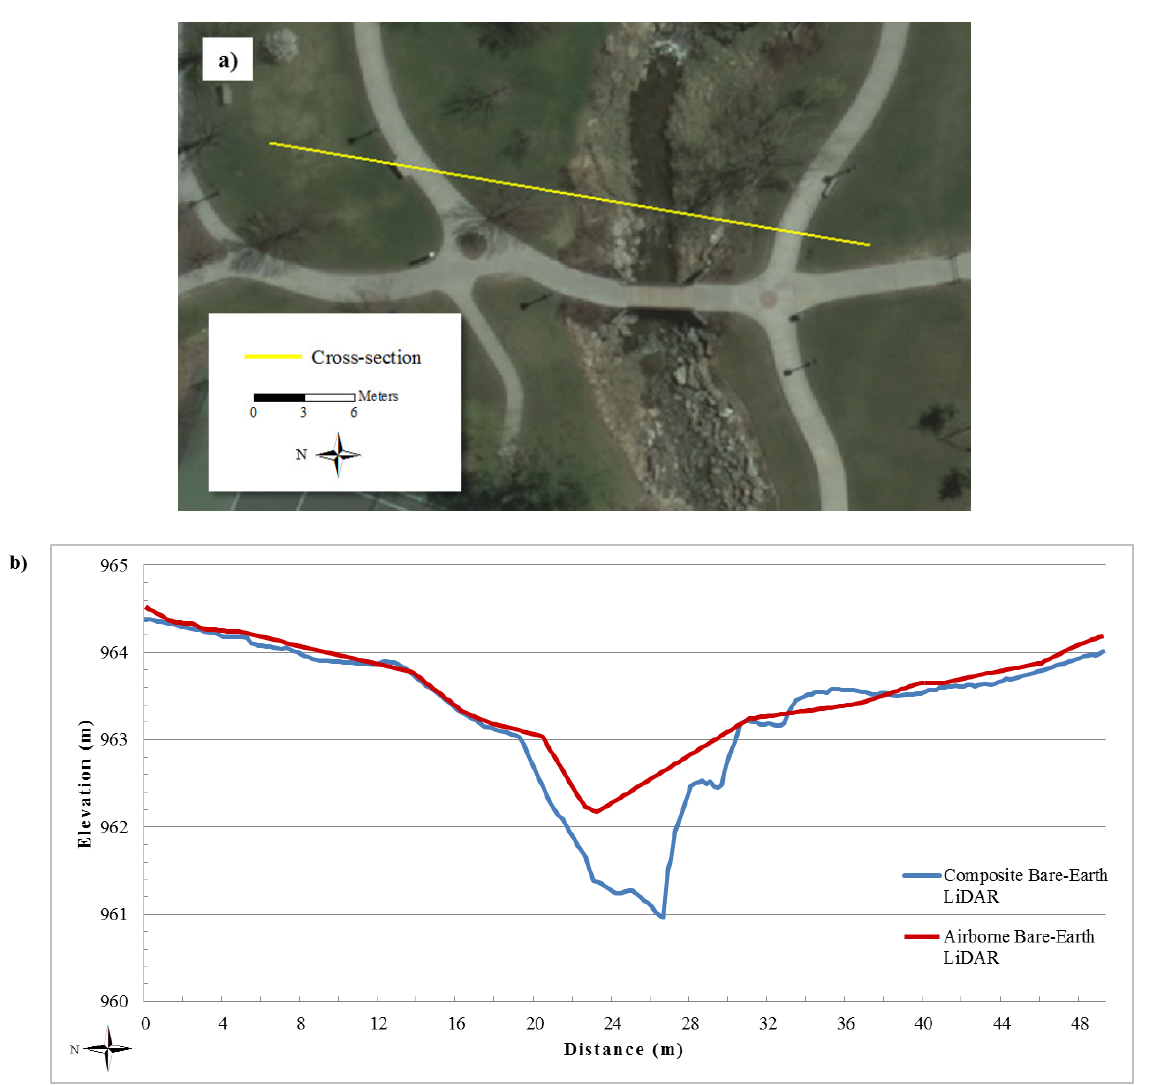
Figure 8. An example of one of twelve cross-sections drawn perpendicular to the study stream reach for elevation value extraction. ( a ) Aerial view of the cross-section location within the study area on 2010 6-inch orthoimagery [44]; ( b ) Profile view of elevation values extracted along the cross-section from the bare-earth airborne LiDAR TIN dataset and bare-earth composite LiDAR TIN